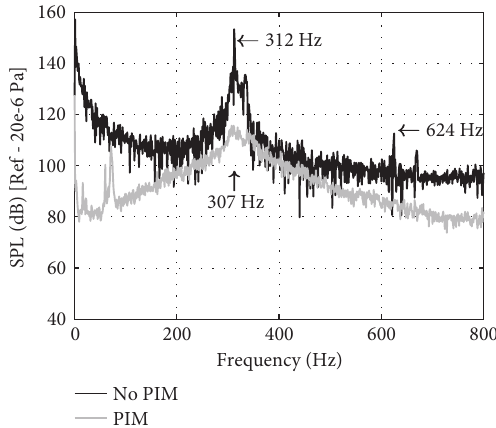
Figure 7: FFT spectra for PIM and no PIM case.